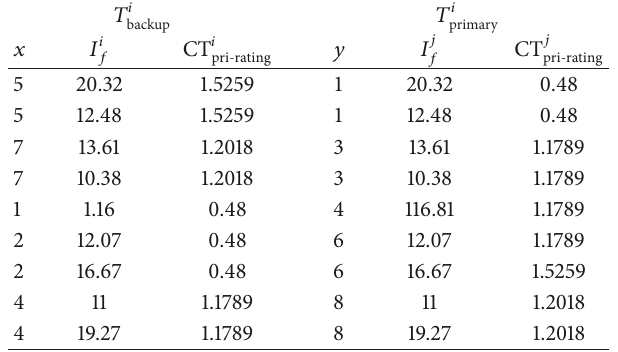
and 𝑇 of 4-bus model. backup primary